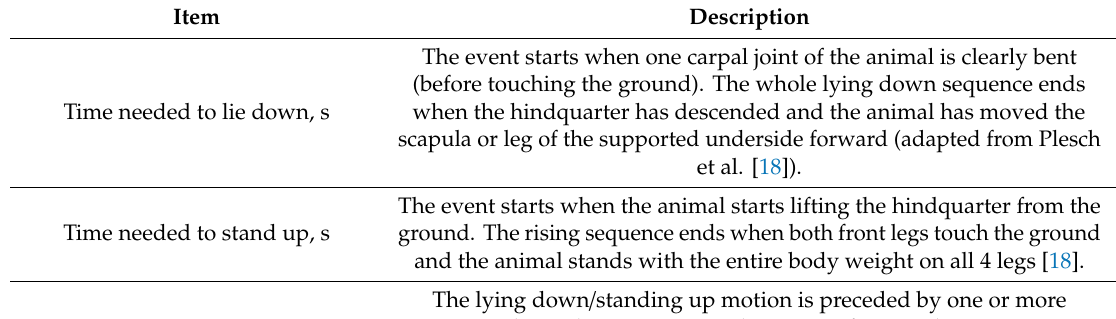
Table 3. Ethogram of behaviors assessed by focal